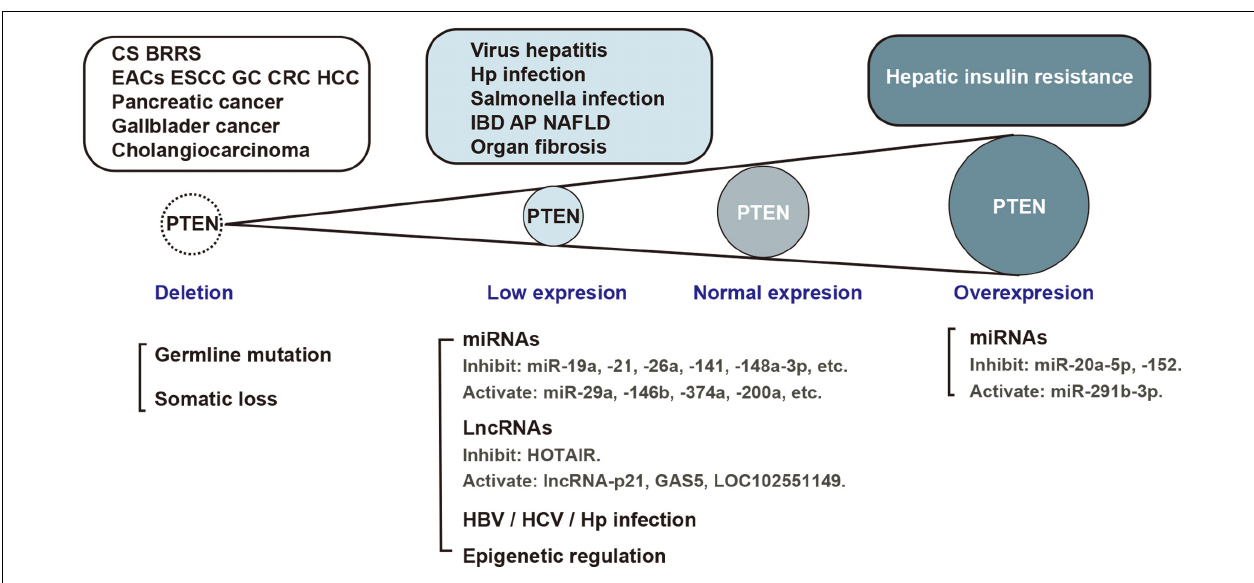
FIGURE 2 | PTEN expression in the pathological process of digestive system diseases. Aberrant PTEN expression is implicated in several diseases of the digestive system. Gene mutation, translational or post-translational regulation is involved in the pathological process. EACs, esophageal adenocarcinomas; ESCC, esophageal squamous cell carcinoma; GC, gastric cancer; CRC, colorectal carcinoma; HCC, hepatocellular carcinoma; IBD, inflammatory bowel disease; AP, acute pancreatitis, NAFLD, non-alcoholic fatty liver disease; HBV, hepatitis B virus; HCV, hepatitis C virus; Hp, helicobacter pylori